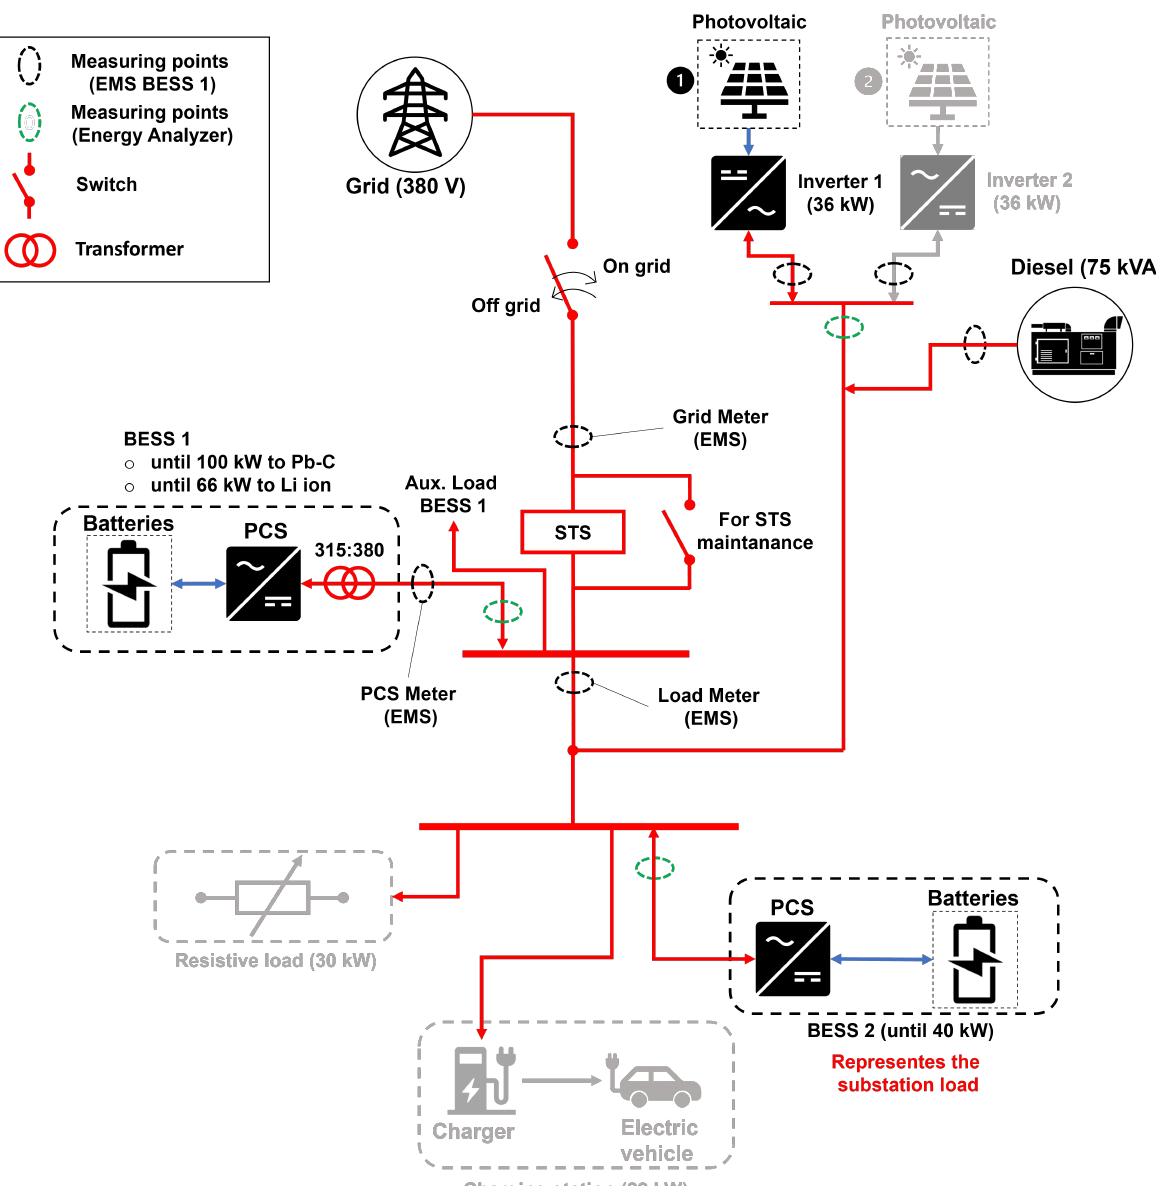
Figure 6. Topology for Chesf microgrid validation